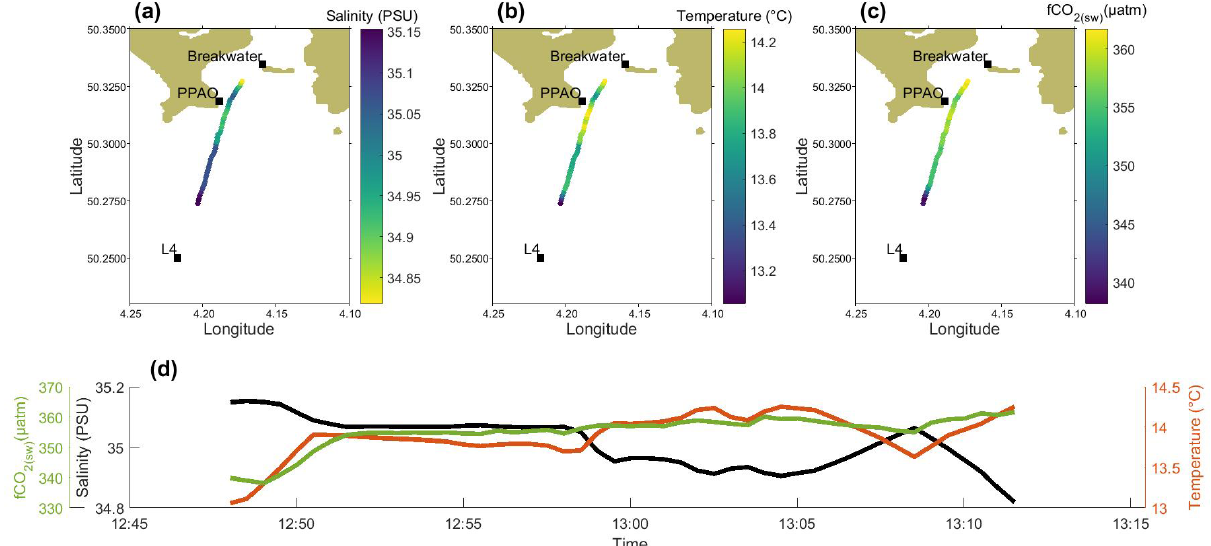
Figure 7. Example of an ebbing tide transect (transect midpoint = LW + 8.75h). Surface measurements of salinity, temperature and f CO 2 represented spatially (a–c) and as a time series (d) from station L4 toward the coast. Data were collected aboard RV Plymouth Quest on 10 June 2016, (filled circles, data every 30s).